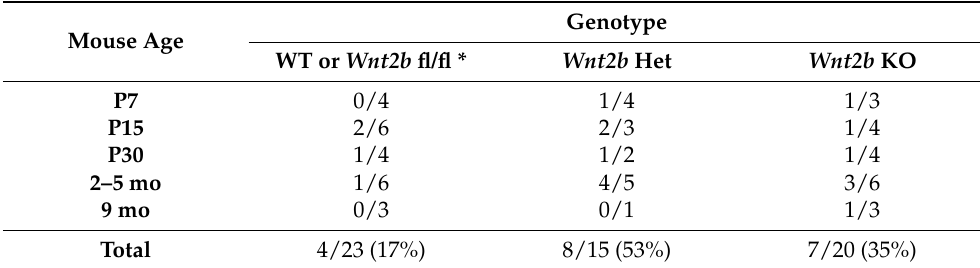
Table 2. Frequency analysis of ectopic photoreceptor phenotype observed in H&E cross sections, organized by age and genotype. Values indicate the number of mice exhibiting phenotype/total number of mice examined.